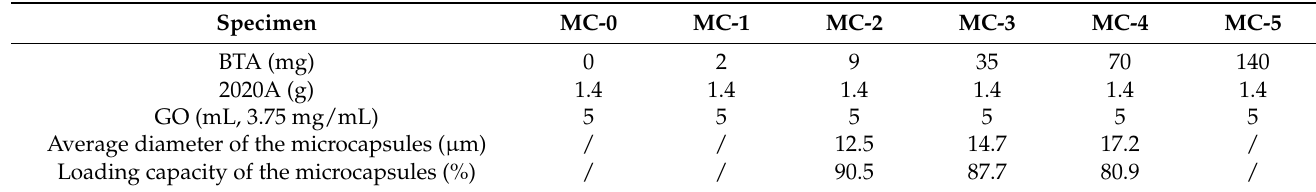
Table 1. The content of the Pickering emulsions for the preparation of the GO microcapsules.